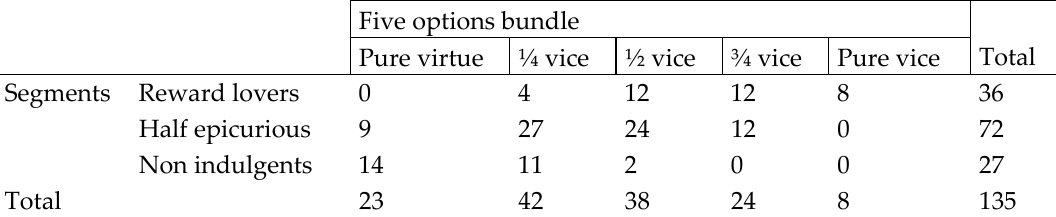
Table D2. Segments food choice. Five options bundle (number of respondents).